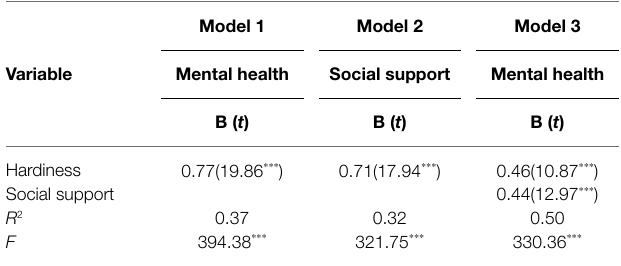
TABLE 3 | Results obtained in the testing of the mediation of social